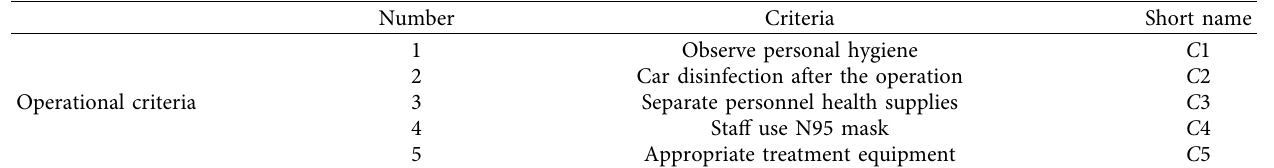
Table 6: Research operational criteria.